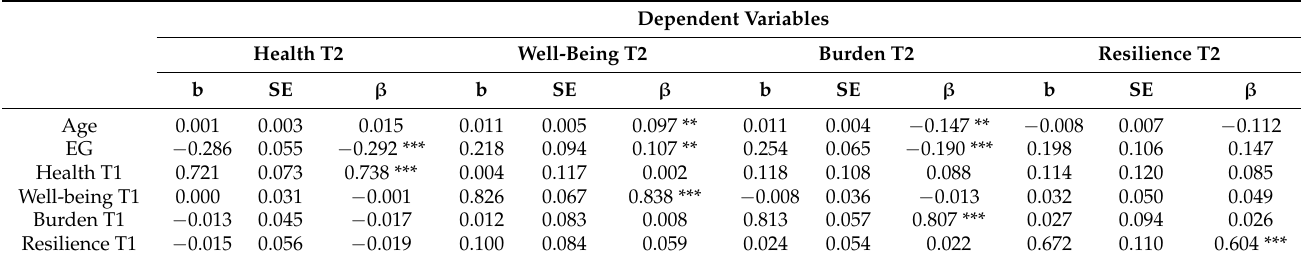
Figure 2. Cross-lagged relationships between health, well-being, burden and resilience at pre-test (T1) and post-test (T2). Model fit: χ 2 (8) = 7.179, p = 0.51, RMSEA = 0.00, CFI = 1.00, SRMR = 0.05. * Correlation is significant at level 0.05; ** Correlation is significant at level 0.01; *** Correlation is significant at level 0.001. Table 5. Directional path in the longitudinal panel model to examine associations between pre-test (T1) and post-test (T2)